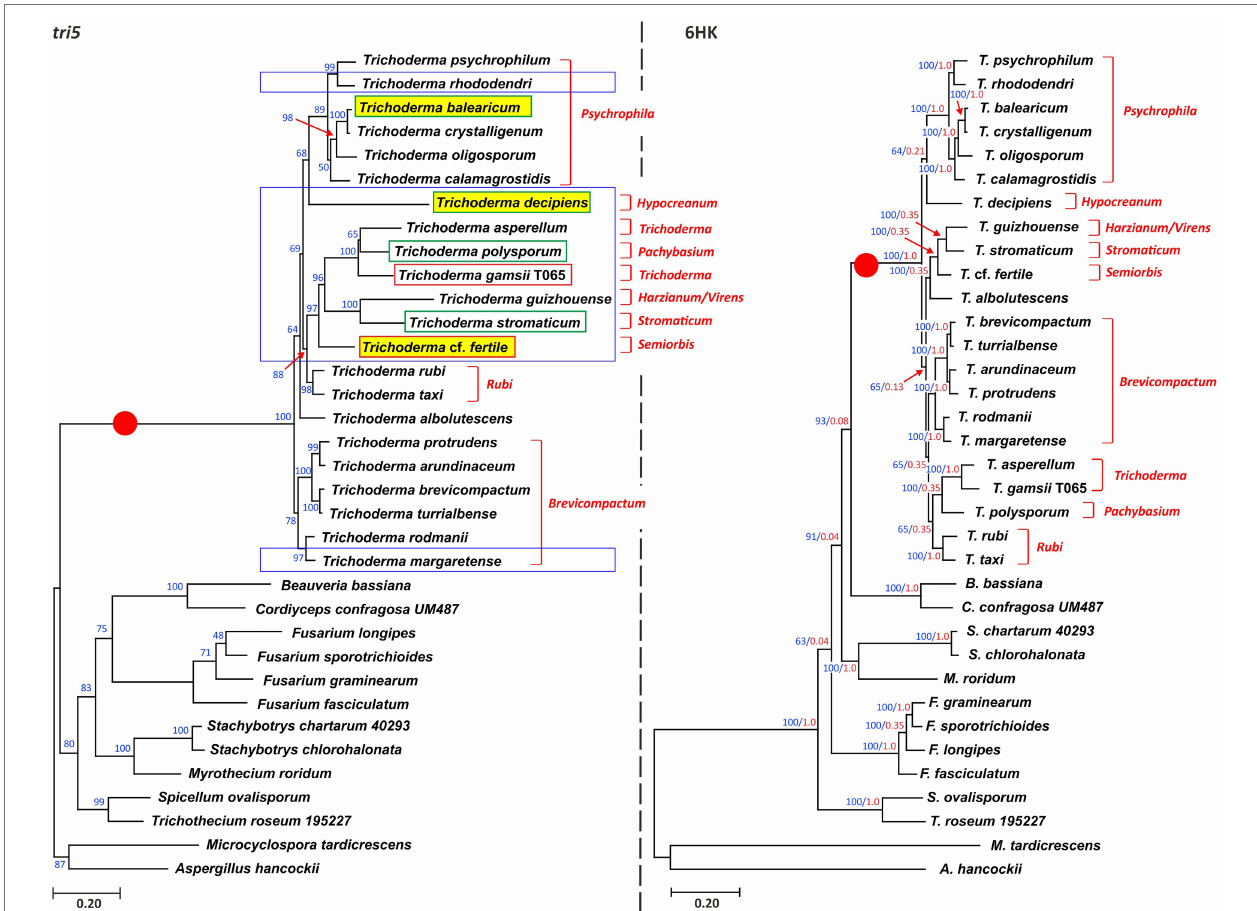
FIGURE 4 | (Left panel) Phylogenetic tree inferred by maximum likelihood analysis of full-length exon sequences of tri5 from Trichoderma species and other fungi. Numbers on each branch are bootstrap values based on 1,000 pseudoreplicates. Blue rectangles denote species that have tri5 but no other tri genes. Red and green rectangles denote species used in the Δ tri5 mutant complementation analysis; a green rectangle indicates successful complementation, and a red rectangle indicates no complementation. Yellow highlighting denotes species that were both used in the complementation analysis and in which tri5 is located at GR1. (Right panel) Phylogenetic tree inferred by maximum likelihood analysis of full-length exon sequences of six housekeeping genes (6HK; Supplementary Table S2 ) from the same species included in the tri5 tree. Numbers on branches are bootstrap values (blue type) based on 1,000 pseudoreplicates and internode-certainly values (red type). In both panels, lineage names, as described previously (Kubicek et al., 2019), are indicated in red type to the right of each tree. The red circle in both trees denotes the different lengths of the Trichoderma branch in the two TABLE 2 | Probability values from a Shimodaira-Hasegawa (pSH) test that assessed whether the original maximum likelihood trees inferred from each sequence alignment was a better fit than trees inferred from other alignments. Alignment Topology